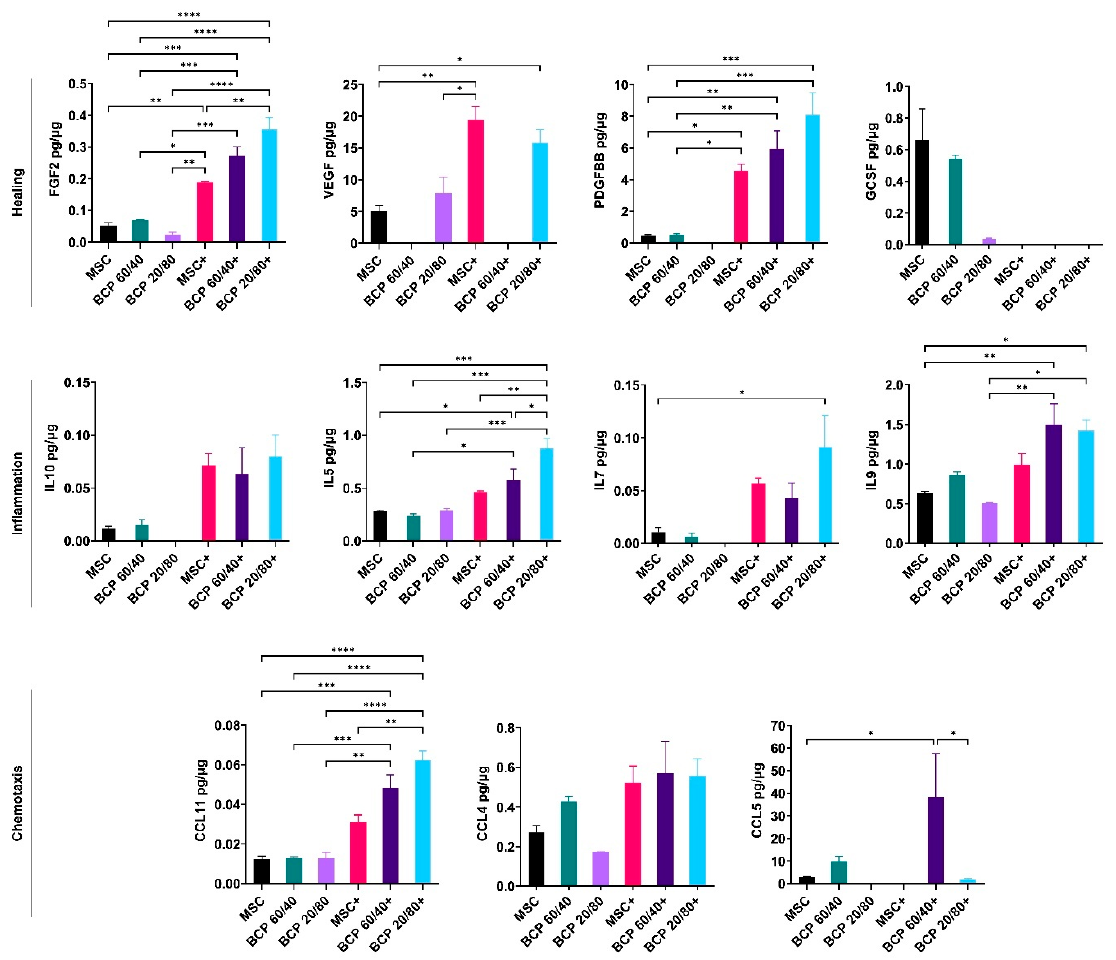
Figure 4. Multiplex cytokine assay of MSCs cultured with BCP granules (BCP 60/40 or BCP 20/80). Cytokines related to healing, inflammation and chemotaxis were measured after 72 h. + indicates cytokine stimulation. Concentration of each analyte (pg/mL) was normalized to total protein concentration of the conditioned media (µg/mL). Statistical analyses are based on one-way ANOVA with Tukey’s multiple comparison tests; * p < 0.05; ** p < 0.001; *** p = 0.0001; **** p < 0.0001.